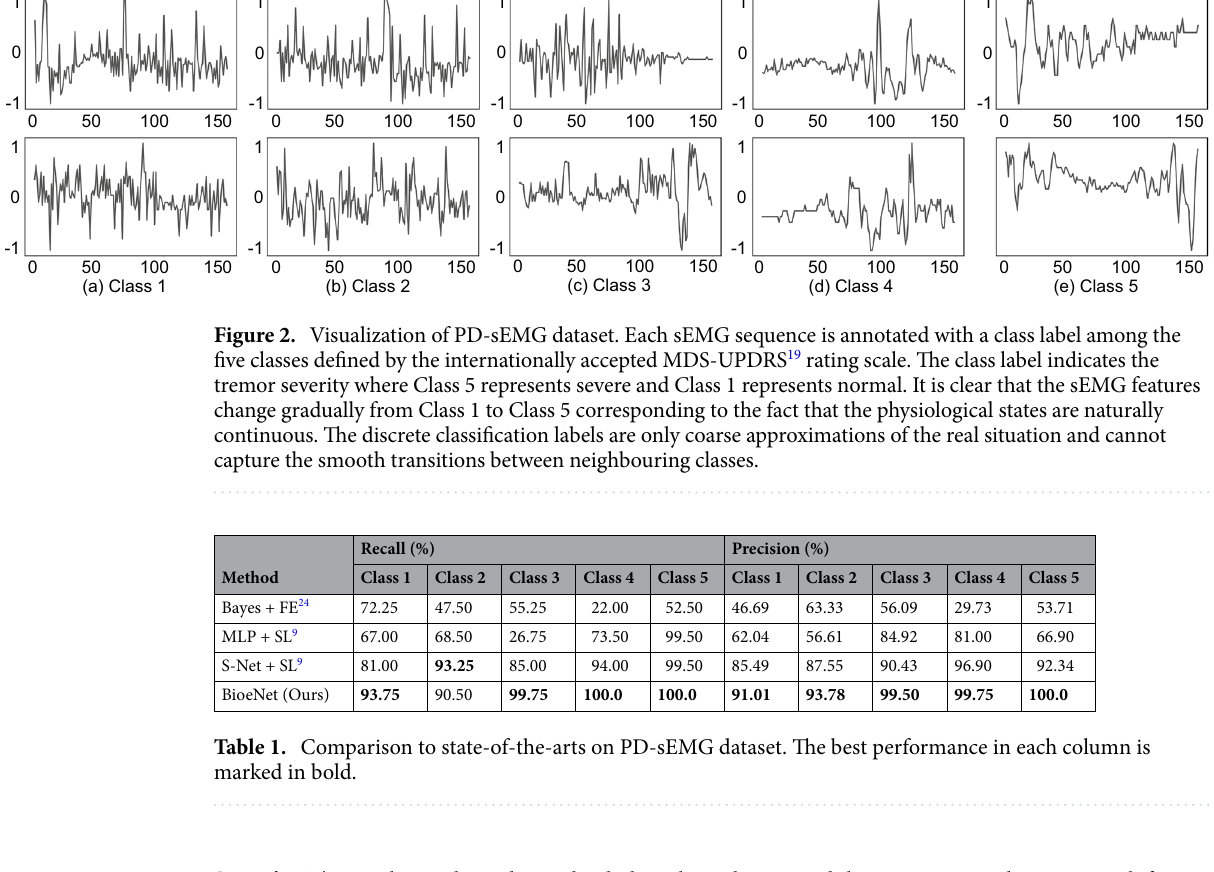
Table 1. Comparison to state-of-the-arts on PD-sEMG dataset. The best performance in each column is marked in bold.